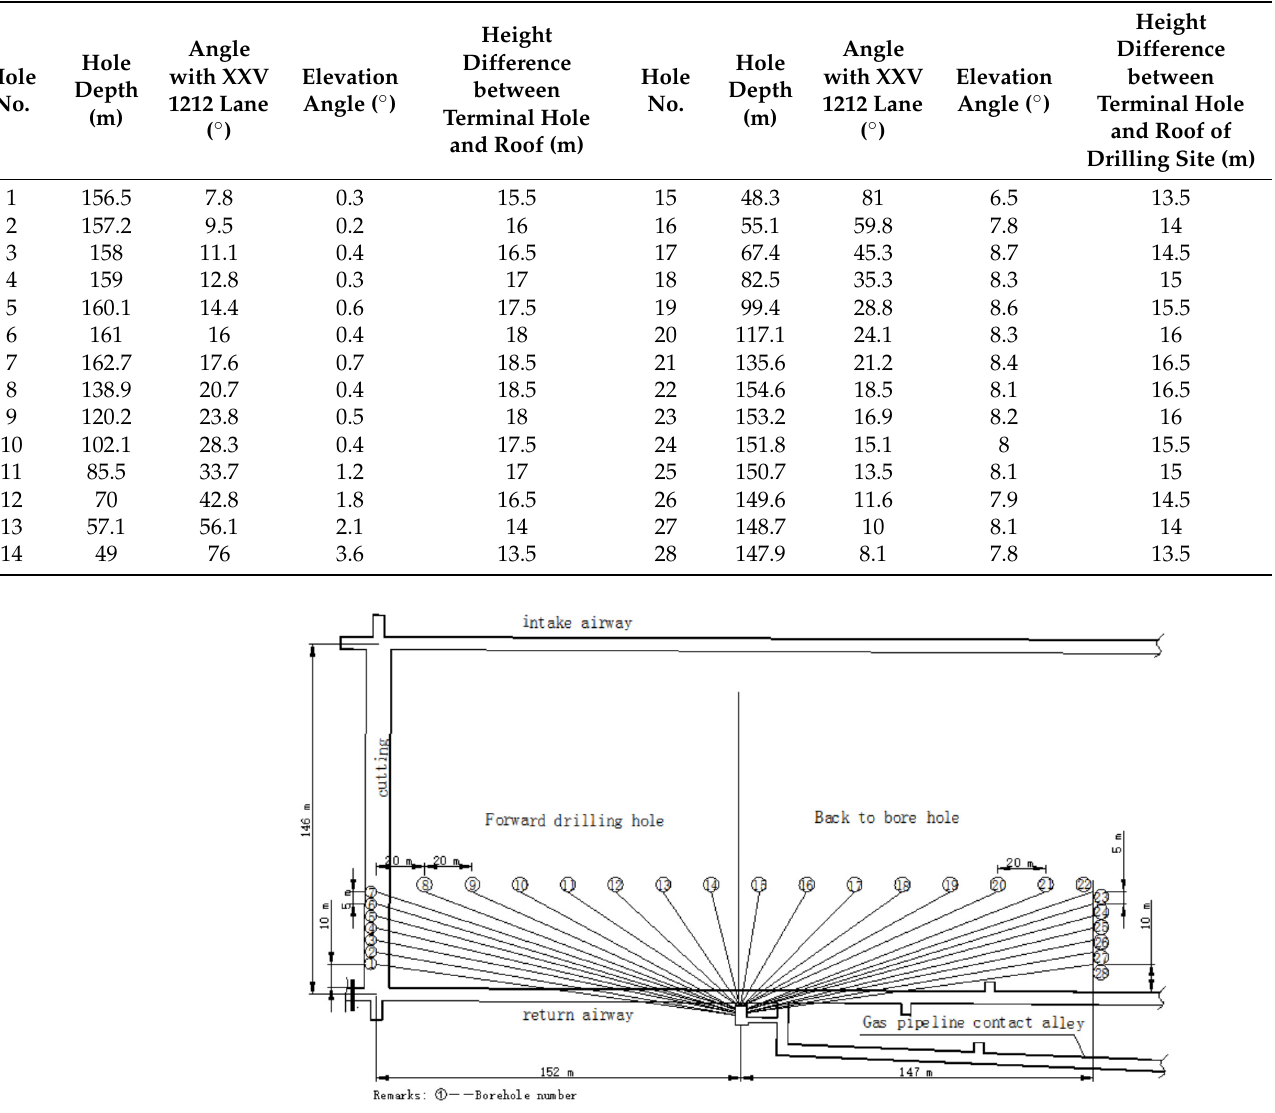
Figure 11. Omni ‐ directional high ‐ level drainage borehole layout. Figure 11. Omni-directional high-level drainage borehole